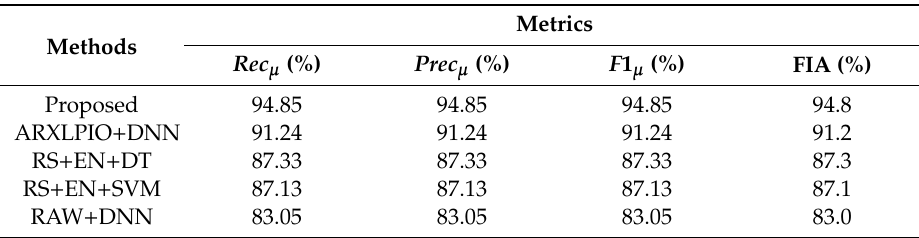
Table 4. The experimental results expressed in terms of Rec µ , Prec µ , F 1 µ , and fault identification accuracy (FIA) averaged over 10 experiments.